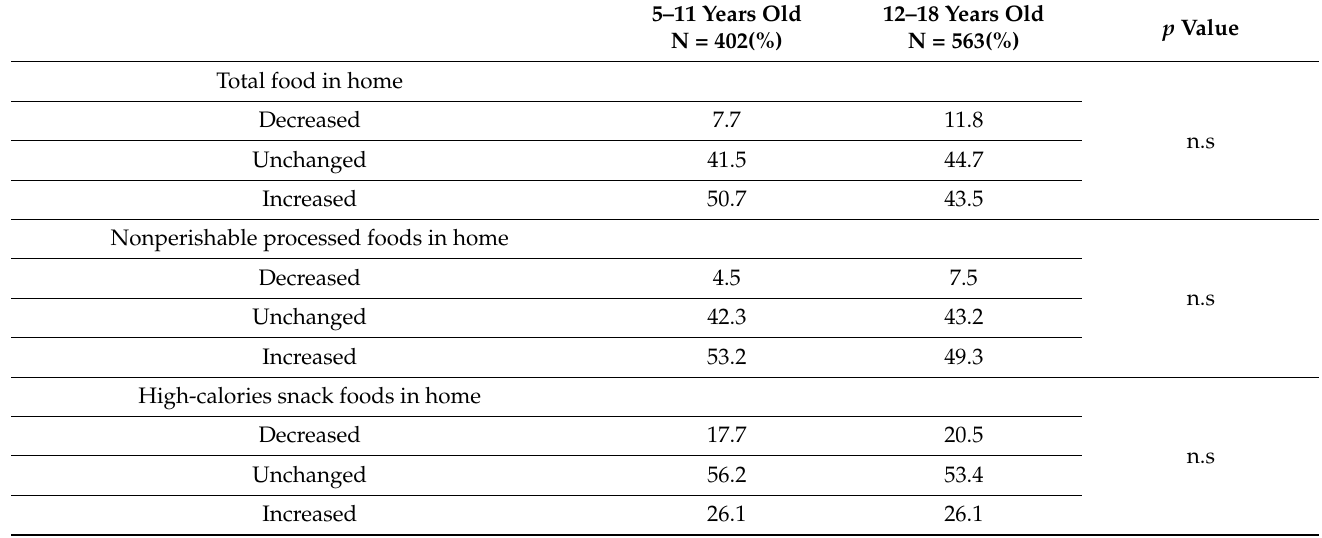
Table 2. Household food amounts during lockdown compared with before the